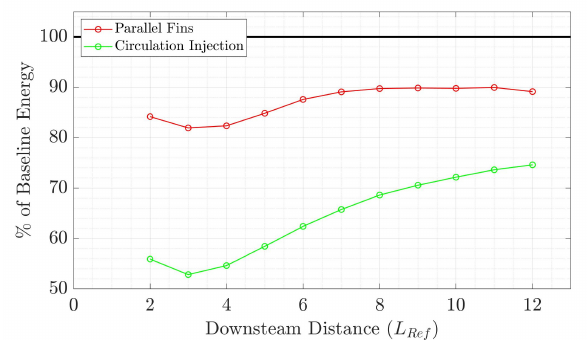
Figure 9. Relative energy of slipstream mode 1.